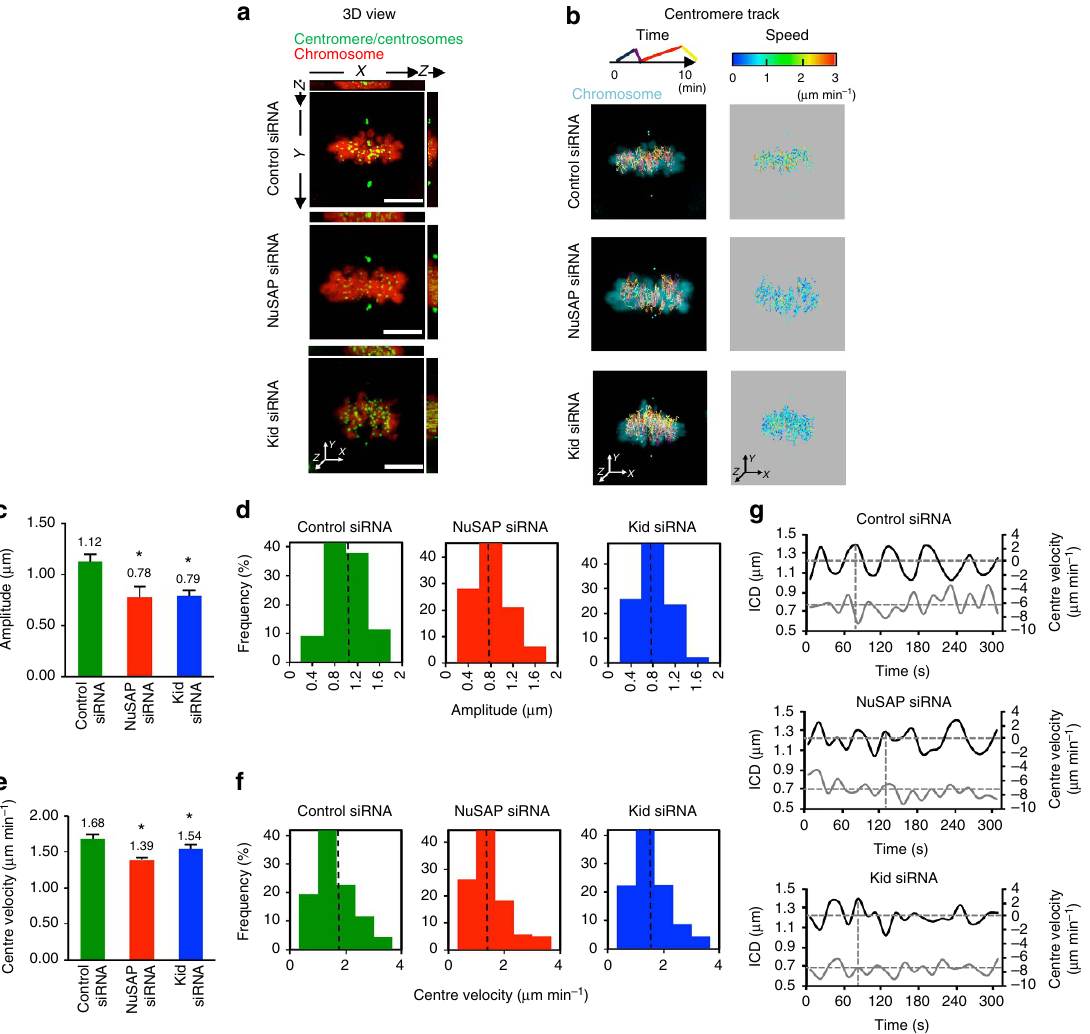
Figure 3 | The depletion of NuSAP or Kid attenuates the amplitude and velocity of centromere movements. ( a ) Representative images of the 3D view using xz and yz projections in the control, NuSAP- or Kid-depleted synchronized metaphase mCherry-H2B HeLa cells. Centromeres were marked with GFP-CENPA and centrosomes with GFP-centrin. Scale bar, 5 m m. ( b ) Representative images of 3D centromere tracks, colour-coded for time and velocity. ( c , d ) Bar chart and histogram representing the average ( c ) and the distribution ( d ) of the amplitude of centromere oscillation in the control, NuSAP- or Kid-depleted metaphase cells. Error bars represent þ s.e.m. * P o 0.001, by t -test. ( e , f ) Bar chart and the histogram representing the average ( e ) and the distribution ( f ) of the centre velocity. Error bars represent þ s.e.m. * P o 0.001, by t -test. ( g ) Representative velocity (solid black line) and ICD (solid grey line) versus time plots of the projected centre in a sister centromere pair in control, NuSAP- and Kid-depleted metaphase cells. The sign of the velocity indicates the direction of the centromere movement. The average of the ICD (horizontal) and the minimum (horizontal) and maximum velocities (vertical) are indicated by dashed